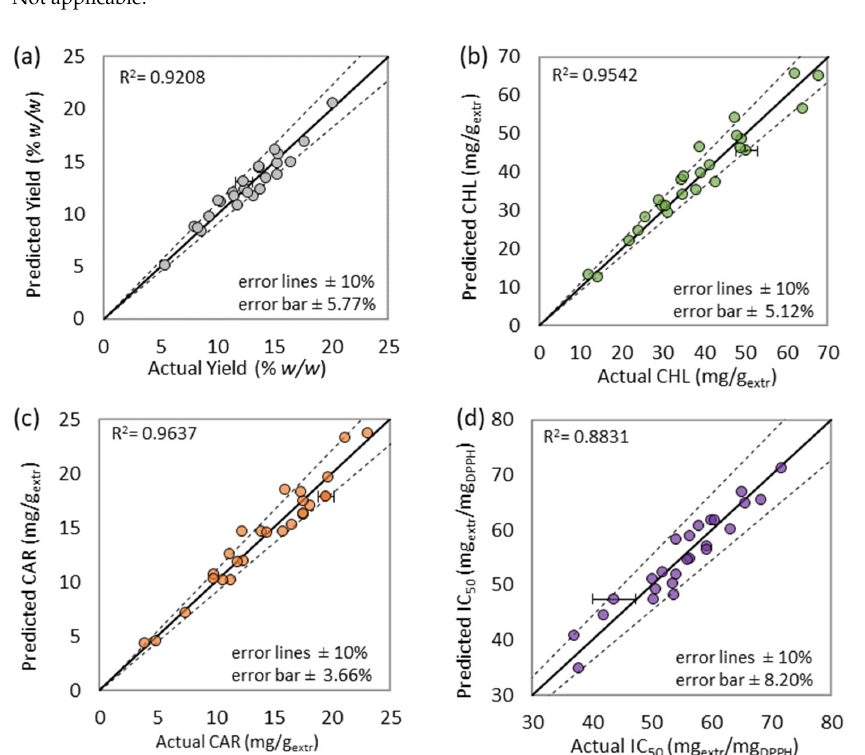
Figure 6. Experimental versus predicted values of ( a ) extraction yield, ( b ) total chlorophyll content, ( c ) total carotenoid content, and ( d ) antioxidant activity. The error bars refer to the experimental coefficient of deviation.